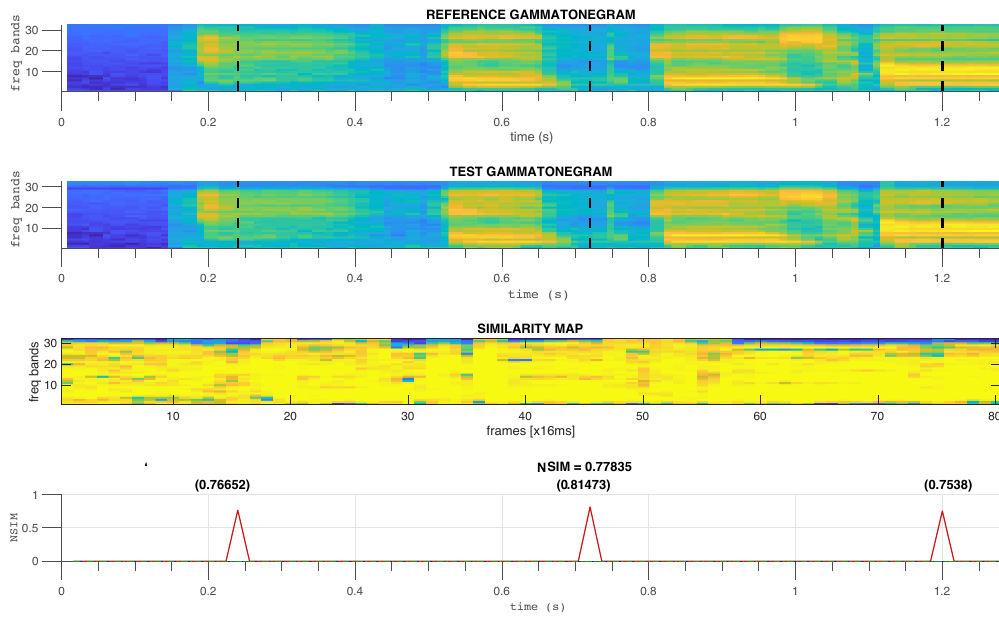
Figure 5. NSIM scores derived from the Similarity Map between Reference and Test Gammmatonegrams. Further examples and descriptions can be found in